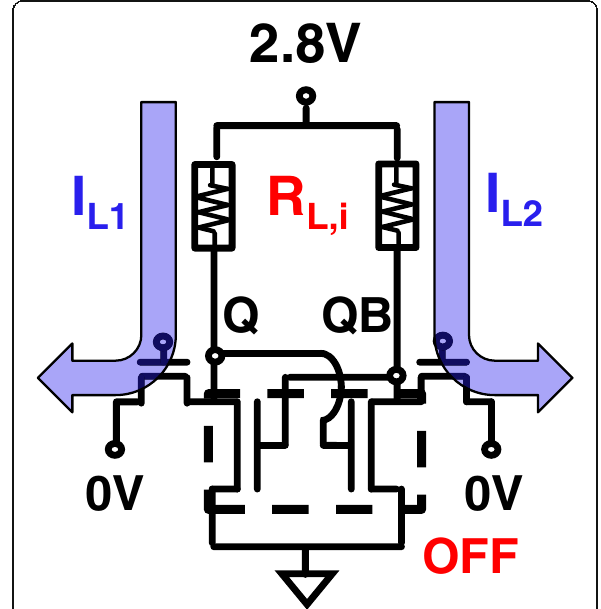
Fig. 13 V T variation leads to different initialization compliance I L,1 and